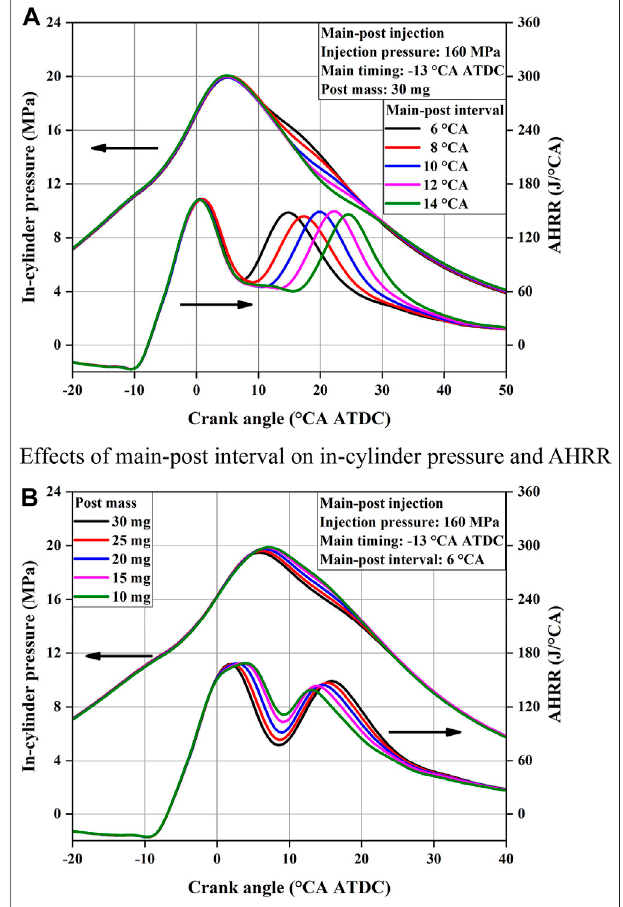
FIGURE7| Effectsofpilot-mainintervalandpilotmassonemissions. (A) Effects of pilot-main interval on emissions, (B) Effects of pilot mass on emissions.